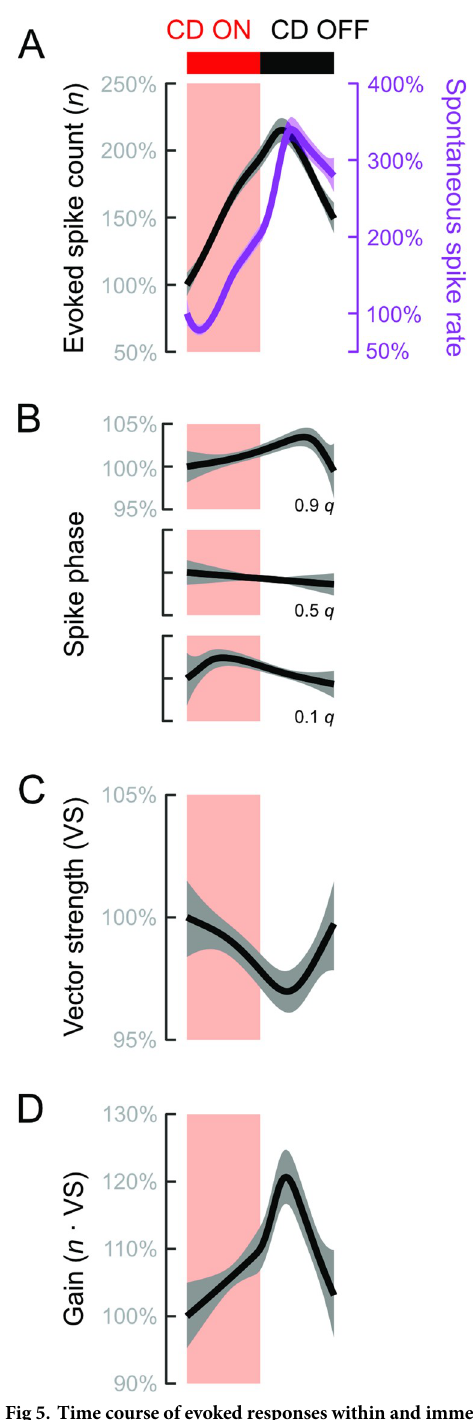
Fig 5. Time course of evoked responses within and immediately after swim bouts. All response were normalized to the start of the swim. (A) Evoked spike counts and spontaneous spike rates (green) increased to a peak after the end of the swim. (B) Response phases exhibited a complex pattern over the course of the swim bout. Early (0.1 q ) and late (0.9 q ) spikes exhibited opposite trends. Median spike phase (0.5 q ) remained nearly constant over the swim duration. (C) VS declined to a minimum in the post-swim period, which is related to the opposite trends of the 0.1 and 0.9 q . (D) Gain increased over the swim to a maximum in the post-swim period. p < 0.001 for all smooth functions in each panel. The data and code underlying this figure may be found at DOI: 10.6084/m9.figshare.13034012. CD, corollary discharge; VS, vector